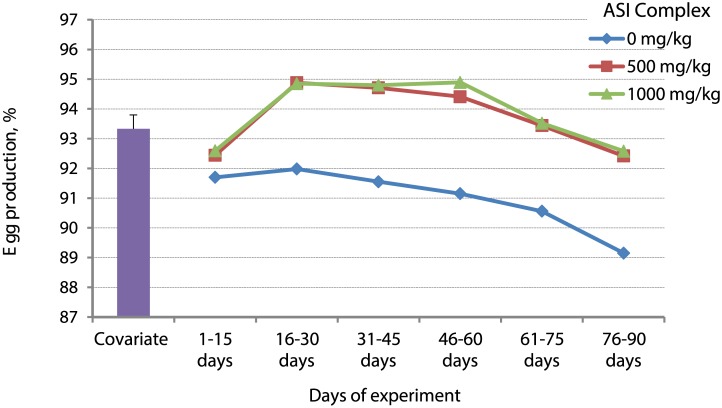
Effects of ASI (arginine-silicate-inositol) complex (♦, 0 mg/kg; ■, 500 mg/kg; ▲, 1000 mg/kg) supplementation on egg production.Covariate is average initial egg production of all chickens first 7 days prior to the experimental period at age of 25 weeks. Pooled SEM = 0.27.